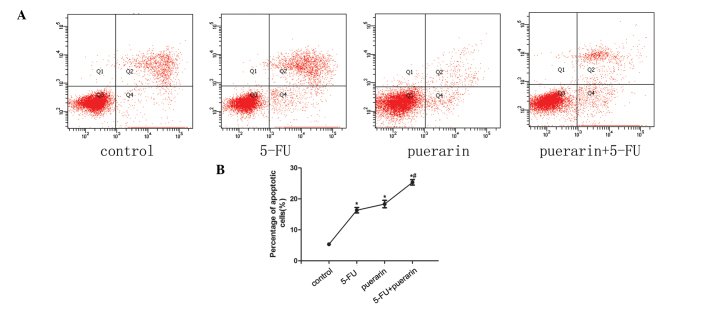
Annexin V/PI apoptosis kit was used to quantify the percentage of cells undergoing apoptosis (X axis, Annexin V; Y axis, PI). (A) Flow cytometry results. (B) Percentage of apoptotic cells in each group. Puerarin combined with 5-FU or used individually significantly promoted apoptosis compared to the control group (*P<0.05), and the combined effect was stronger than the effect of puerarin or 5-FU alone (#P<0.05). 5-FU, 5-fluorouracil; PI, propidium iodide.